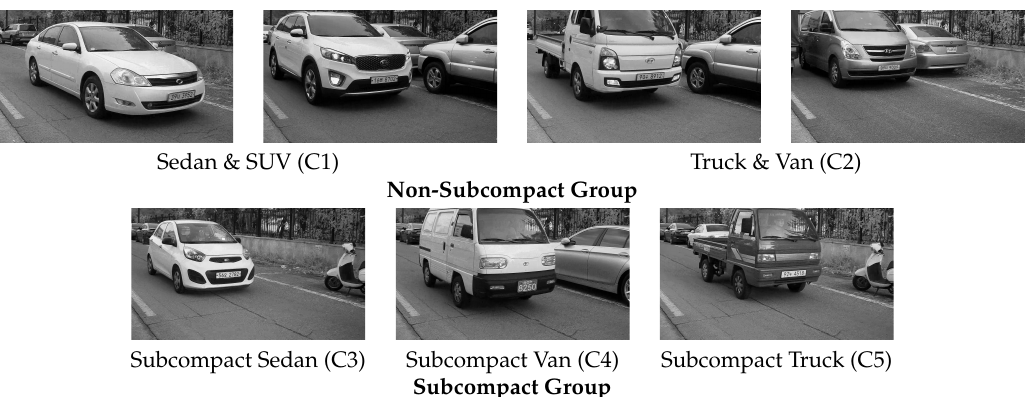
Figure 5. An example of five vehicle classes in the proposed